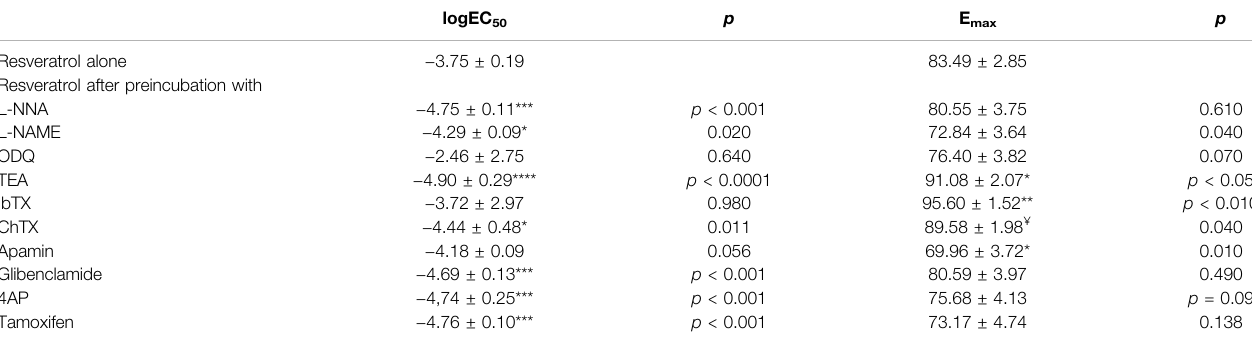
TABLE 1 | Log EC 50 and E max for resveratrol on carbachol-induced contractility of the human gastric muscles. The values are mean ± SD of n (cid:1) 10 individual gastric strips from different patients. * p < 0.05, ** p < 0.01, *** p < 0.001, **** p < 0.0001 versus resveratrol alone; ¥ p < 0.05 versus preincubation with IbTX. logEC 50 p E max p Resveratrol